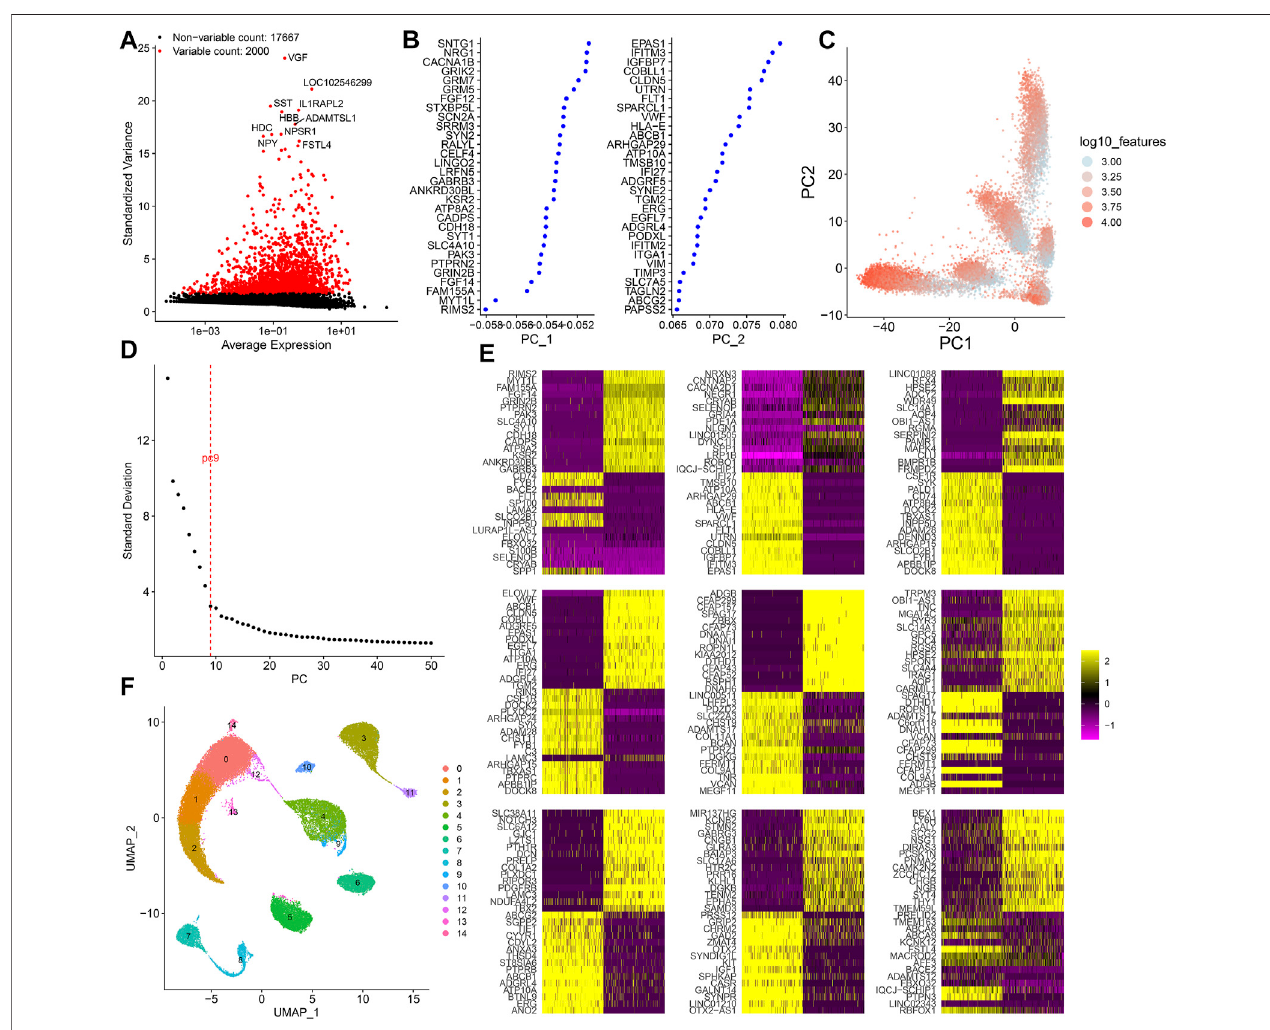
FIGURE2 | Dimensionality reduction analysis ofscRNA-seq. (A) Most variable 2000genesamong cells. (B) First two PCsofthe normalized data. (C) Visualization ofPCAresultsinallcells. (D) ElbowplotfordeterminingtheoptimalnumberofPCs.WhenPC=9,thestandarddeviationwasrelativelysmall. (E) Heatmapforthetop30 feature genes for the fi rst 9 PCs. (F) Cell clusters based on UMAP. Each cluster is identi fi ed by a unique